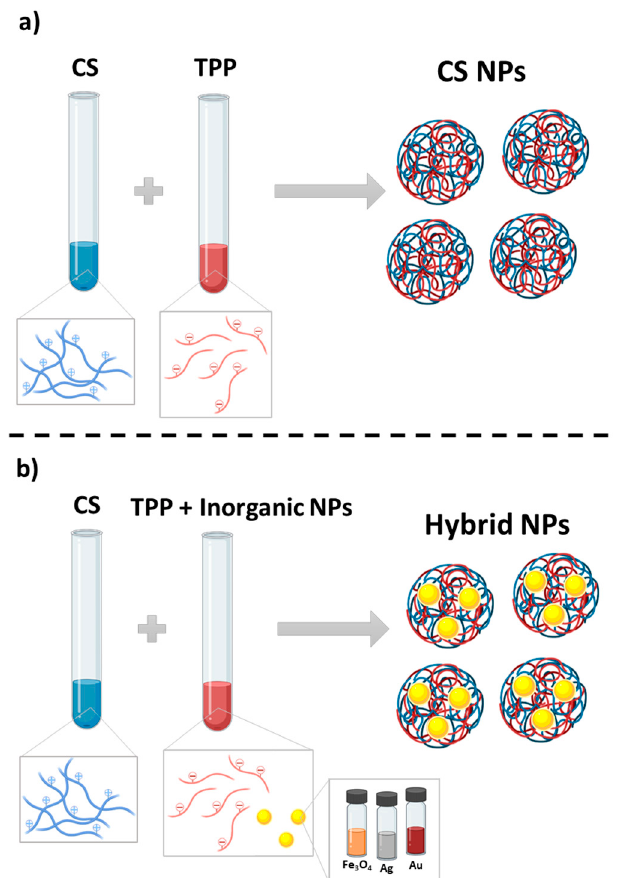
Table 2. Yields of ionotropic gelation-based syntheses of CS and CS-based hybrid NPs and their chemical composition